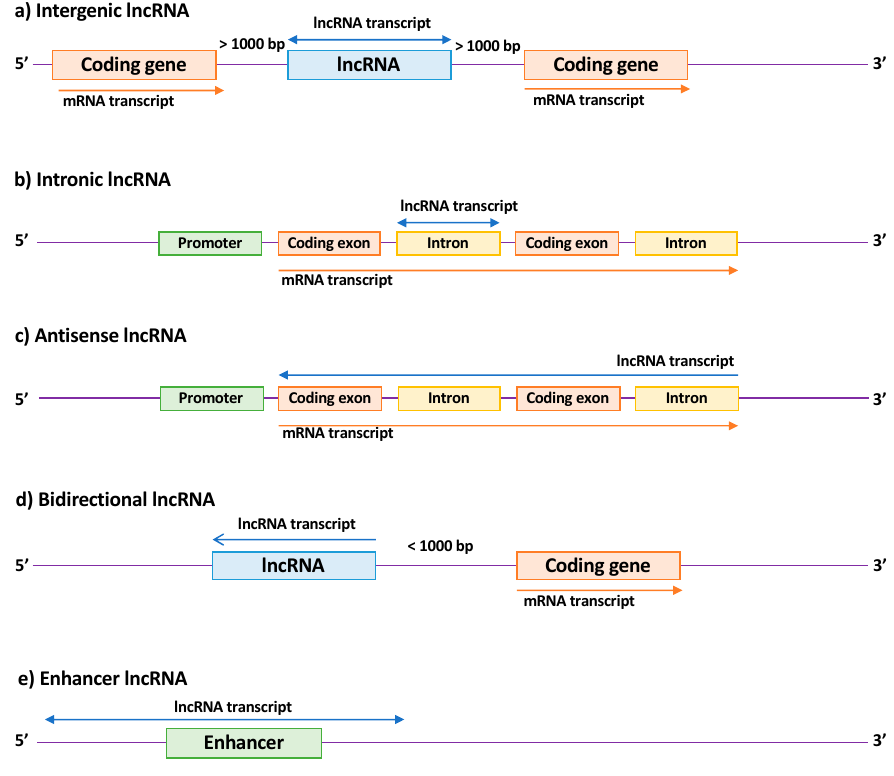
Figure 2. Classification of long non-coding RNAs (lncRNAs) according to their genomic location. ( a ) Intergenic lncRNAs are located between two coding genes; ( b ) intronic lncRNAs are transcribed entirely from introns of protein-coding genes; ( c ) antisense lncRNAs are transcribed from the antisense strand of a coding gene and overlap at least one exon; ( d ) bidirectional lncRNAs are localized within 1 kb of the promoter of a coding gene and oriented in the other direction; ( e ) enhancer lncRNAs are located in enhancer regions associated with a coding gene. Arrows indicate the direction of transcription.